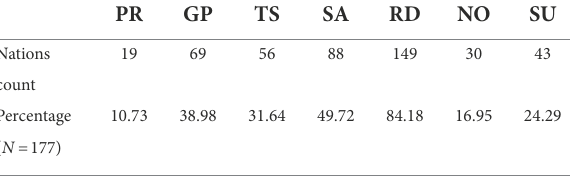
TABLE 3 Distribution of language provisions across nations.